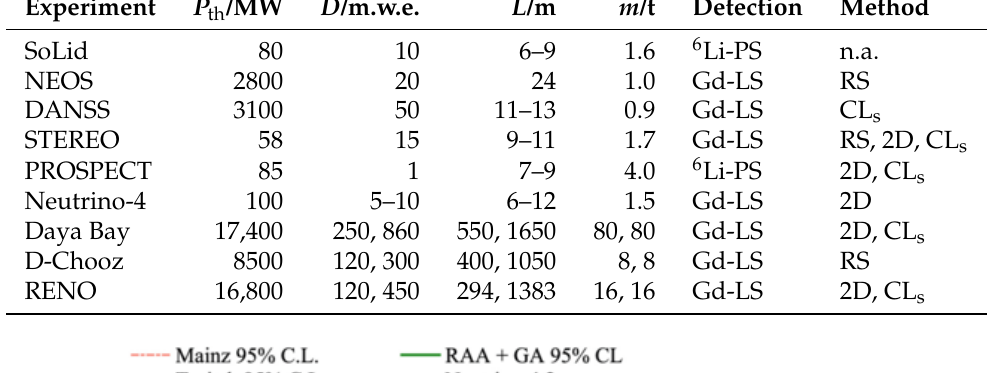
Table 1. Comparison of the experimental parameters (reactor thermal power P th , water equivalent overburden D , baseline L , target mass m ), detection technique and statistical method used in the search for sterile neutrinos at reactors. If more than one detector site or method exists, a full list is given.